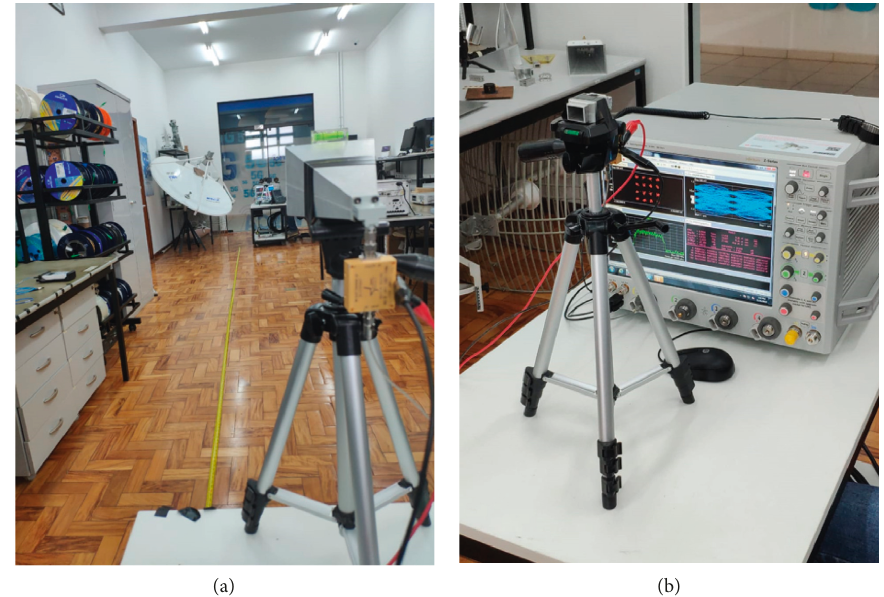
Figure 11: Implementation of the mm-wave tunable horn filtenna at 24.7GHz. (a) Transmission side and (b) reception side.